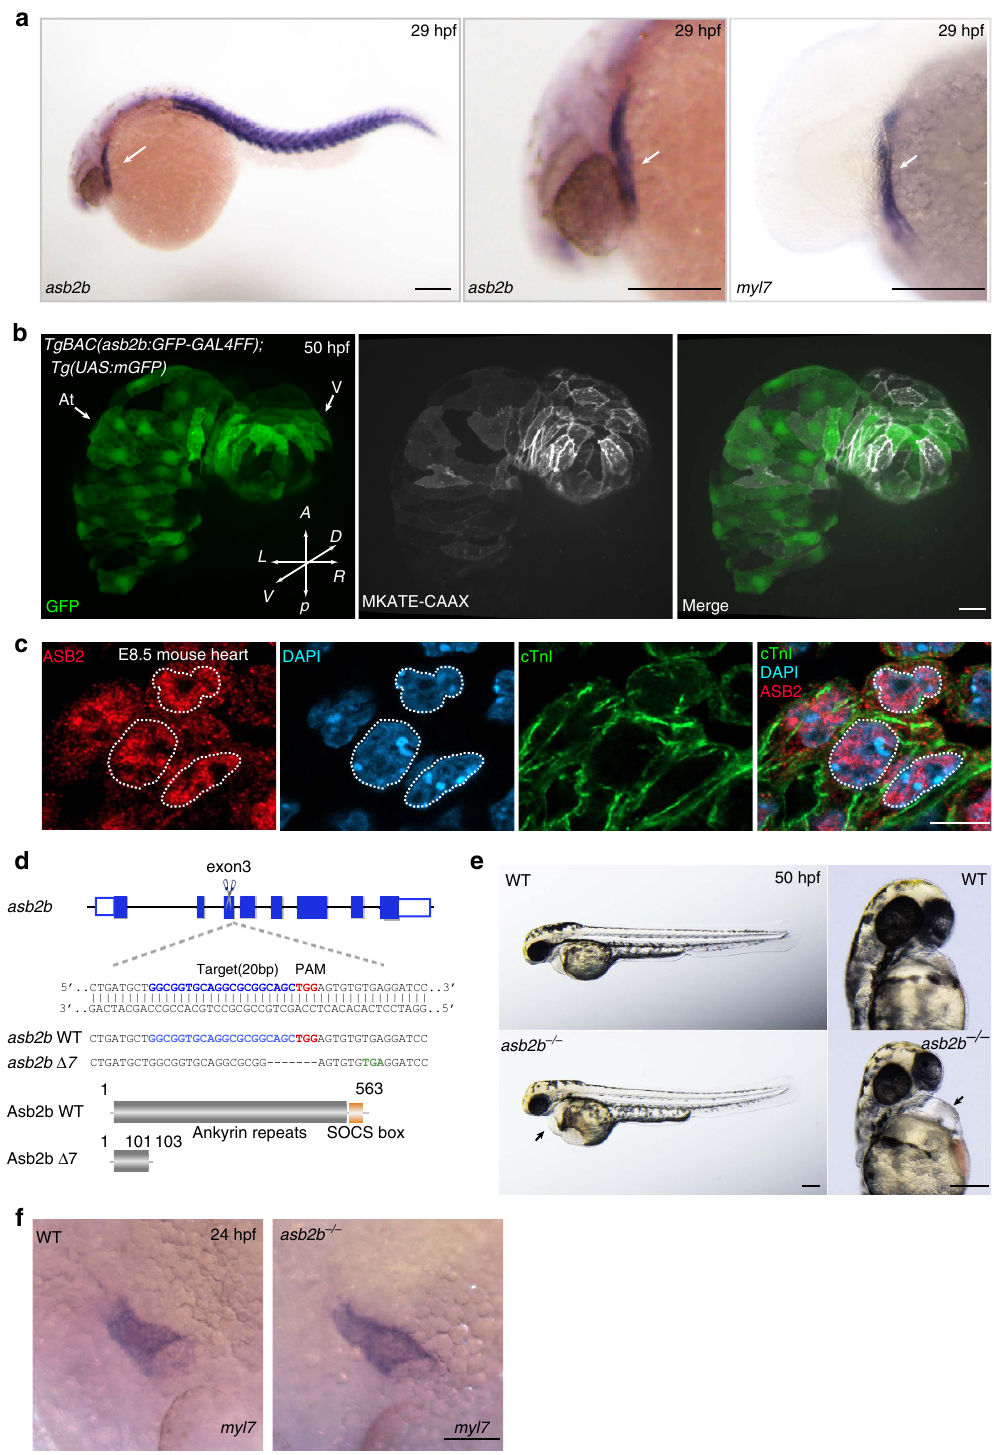
Figure 1 | asb2b mutant zebrafish exhibit cardiac defects. ( a ) In situ hybridization for asb2b and myl7 expression in 29 hpf embryos. asb2b is expressed in the myl7 þ heart tube (arrows) and in the somites. Lateral views, anterior to the left. Scale bars, 200 m m. ( b ) Three-dimensional images of 50 hpf Tg(asb2b:GFP-GAL4FF);Tg(UAS:mGFP);Tg(myl7:MKATE-CAAX) hearts. Scale bar, 40 m m. ( c ) E8.5 mouse heart co-stained for ASB2 (red), cardiac troponin I (cTnI, green) and 4,6-diamidino-2-phenylindole (DAPI; blue), showing nuclear and cytoplasmic localization of ASB2; dashed lines outline nuclei. Scale bars, 10 m m. ( d ) Schematic representation of the asb2b locus. The gRNA target sequence, PAM and premature stop codon are highlighted in blue, red and green, respectively. Deleted nucleotides are indicated by dashes. Predicted structure of WTand mutant (Asb2b D 7) proteins. The asb2b D 7 allele ( asb2b bns33 ) is predicted to encode a truncated polypeptide containing two incorrect amino acids (102–103 aa). ( e ) Bright-field micrographs of 50 hpf WT and asb2b mutant embryos in lateral and ventral views. Black arrows point to pericardial edema. Scale bars, 200 m m ( f ) in situ hybridization for myl7 expression in 24 hpf WT and asb2b mutant. Scale bar, 100 m m. At, atrium; A , anterior; D , dorsal; L , left; P , posterior; R , right; V, ventricle; V ,